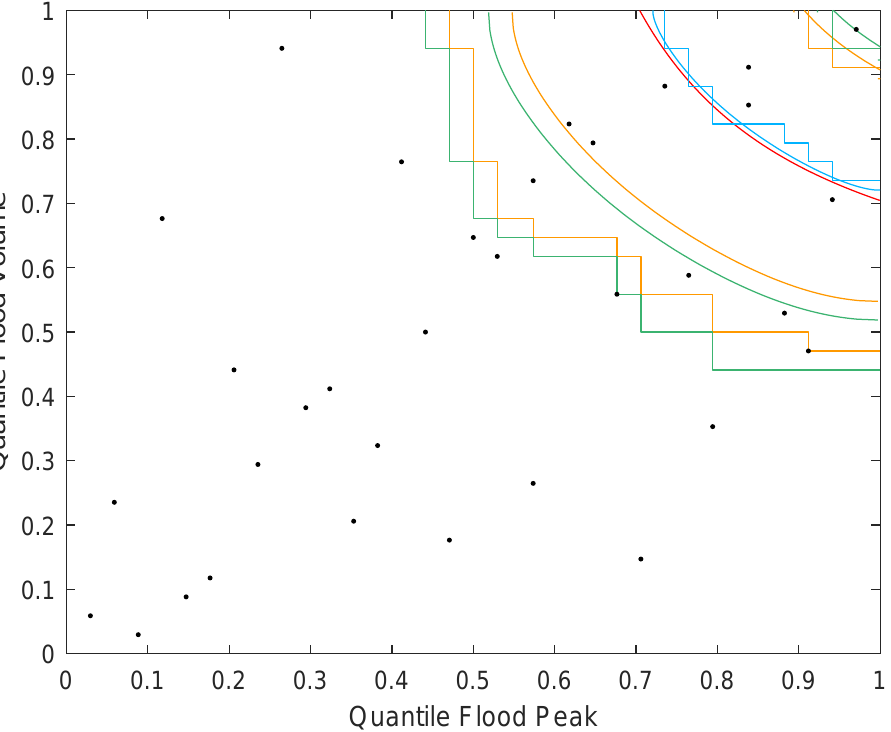
Figure 4. Combined estimation results of the multivariate quantile with both confidence region methods. Boundaries of the estimated multivariate quantiles ˆ S p ( ˆ C ) and ˆ S p ( ˆ C h ) are shown as a blue step curve and a blue smooth curve, respectively. The red curve refers to the boundary of the multivariate quantile of a Clayton copula that is parametrically estimated on the data. Confidence regions of ˆ S p ( ˆ C ) for confidence levels 90% and 95% are depicted as orange and green step curves, whereas the confidence regions of ˆ S p ( ˆ C h ) are shown as orange and green lines for the respective confidence levels.